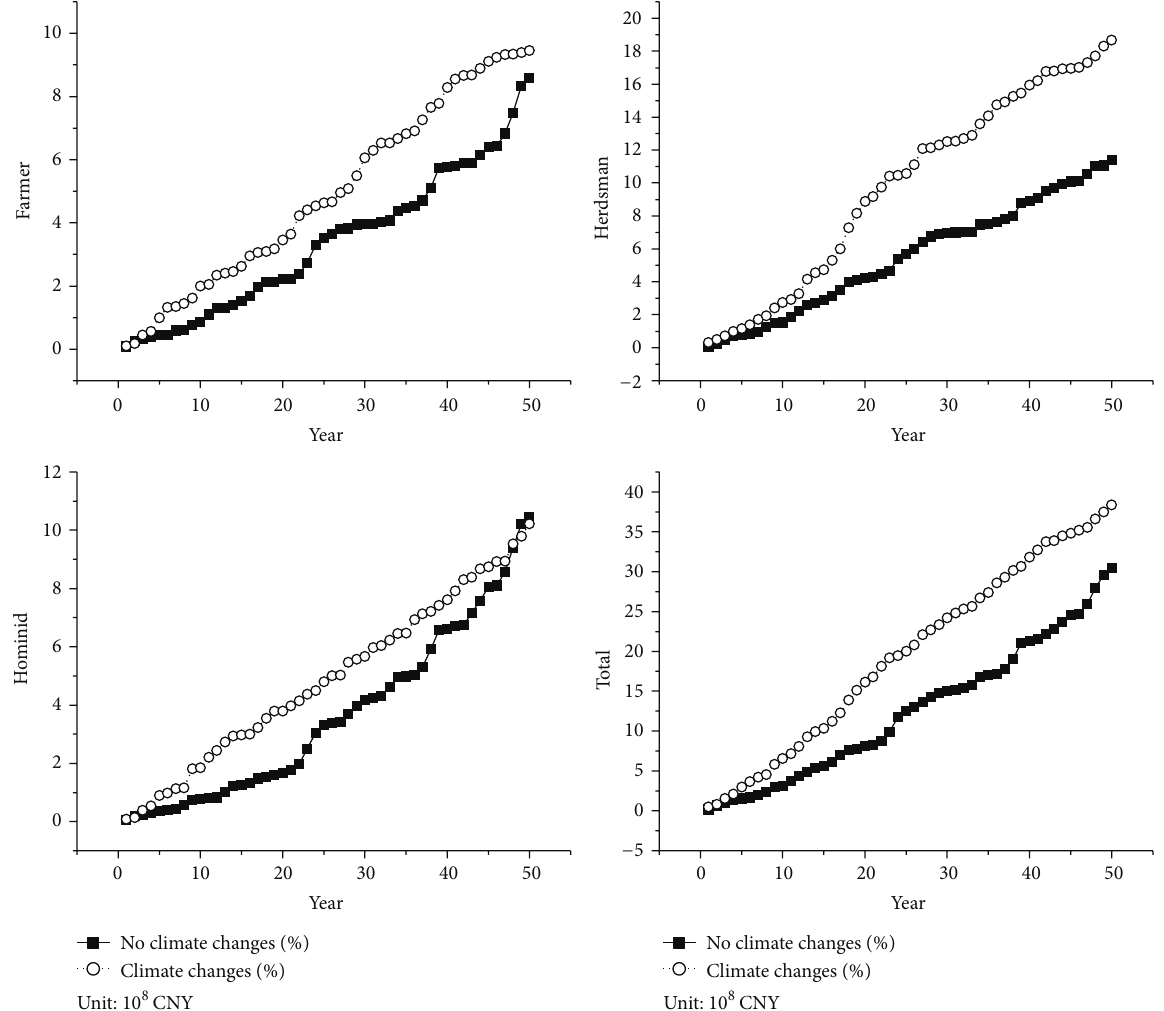
Figure 4: Simulation result of the change of total income of agents under different climate change